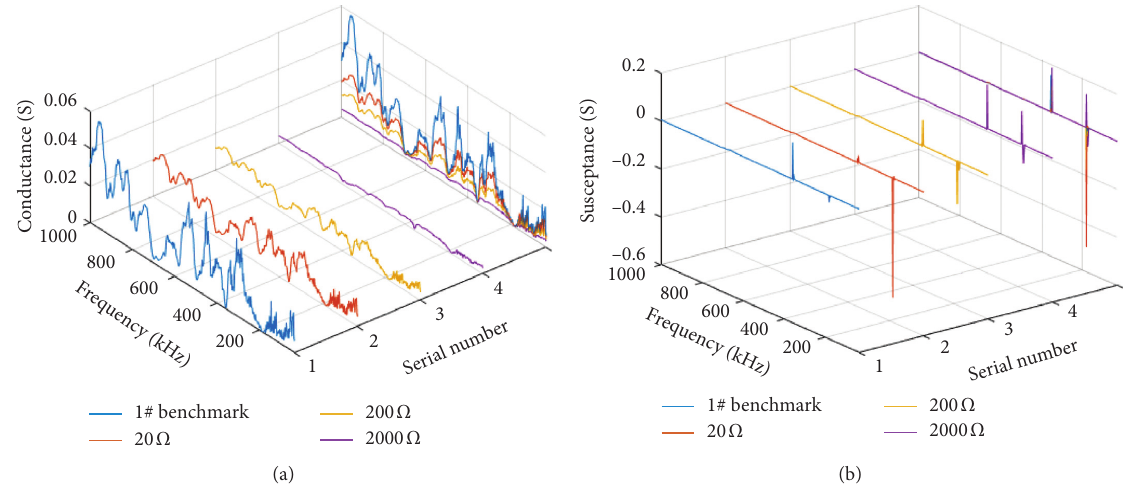
Figure 9: (a) The conductance and (b) the susceptance of 1# PZT under healthy and different pseudosoldering conditions.